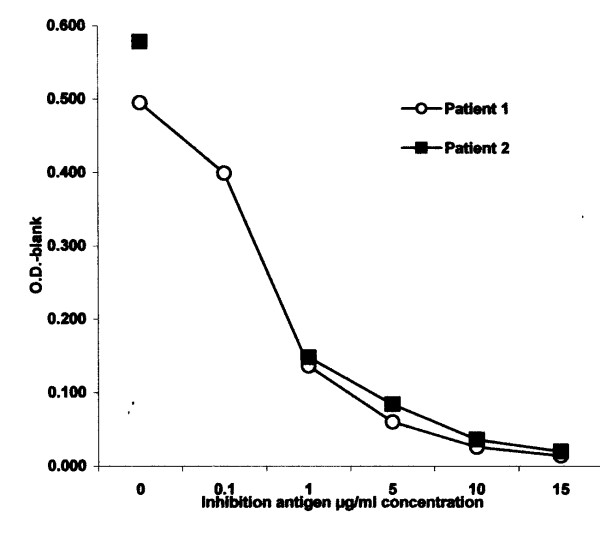
ELISA inhibition assay with guinea pig allergen resulted in complete absorption of specific IgE antibody in both patients.